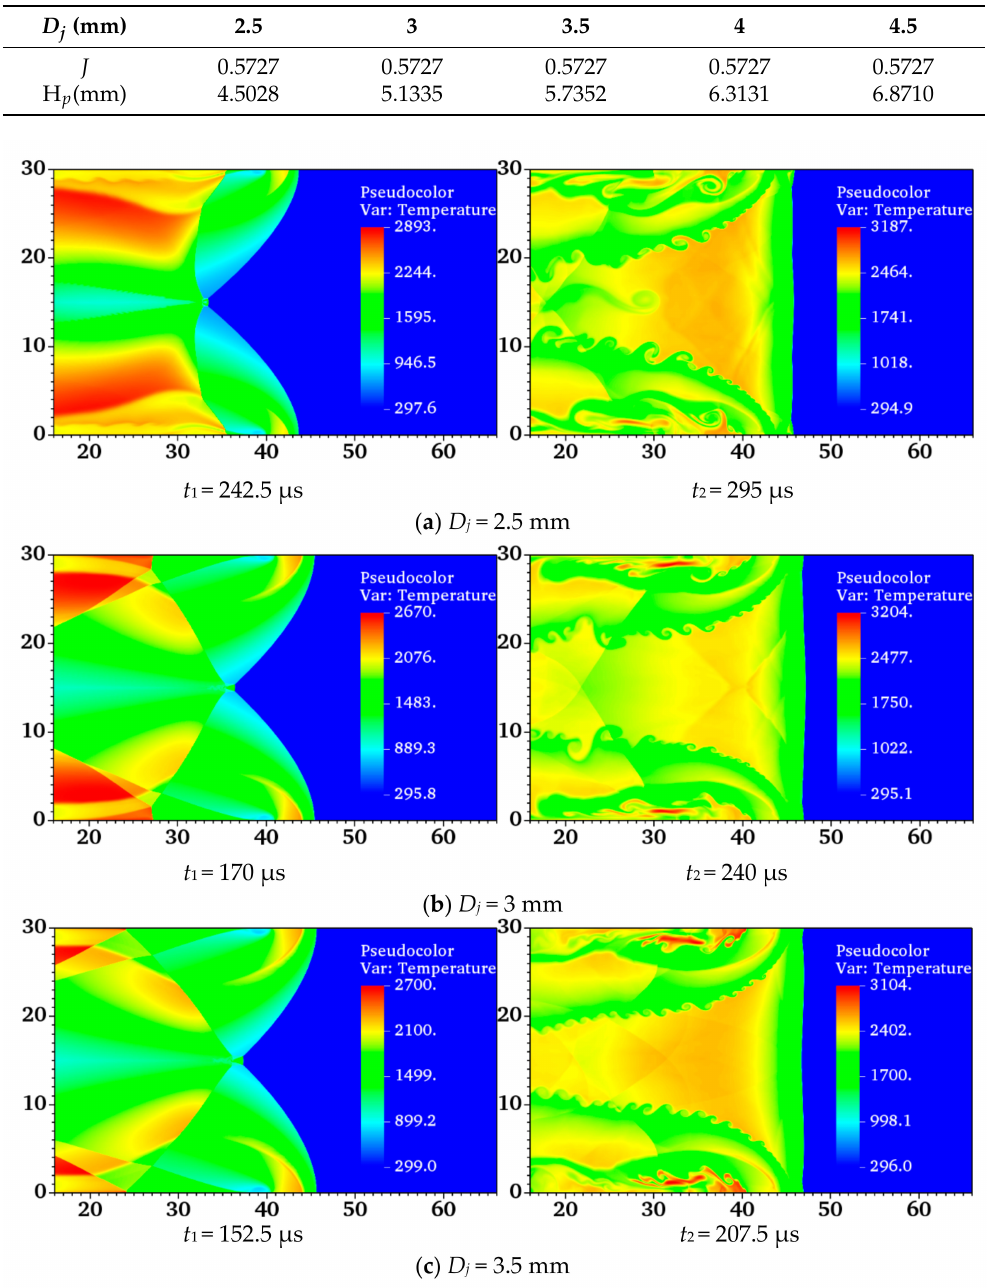
Table 4. Momentum flux ratio J and penetration height H p under different jet diameters.